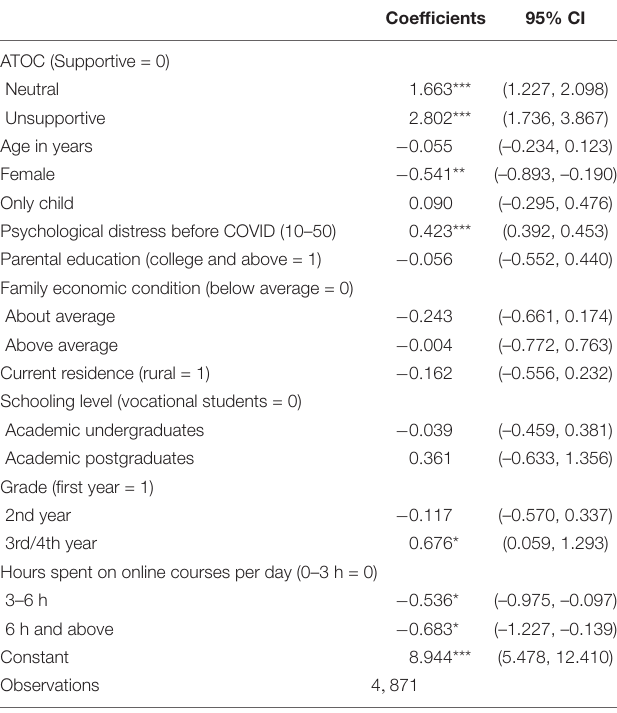
TABLE 4 | Effects of ATOC on during-COVID psychological